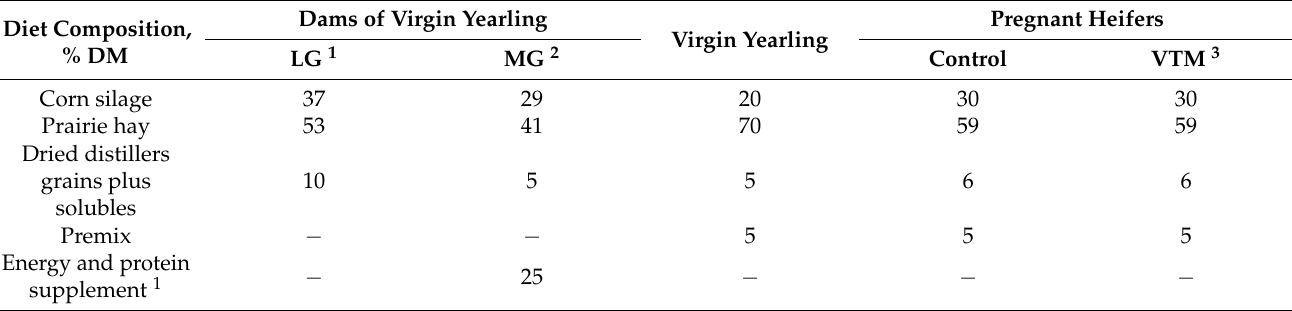
Table 1. Nutrient composition of the diets fed to the dams of virgin yearling heifers during the first 84 days of gestation, and virgin yearling heifers and pregnant heifers at the time of sample